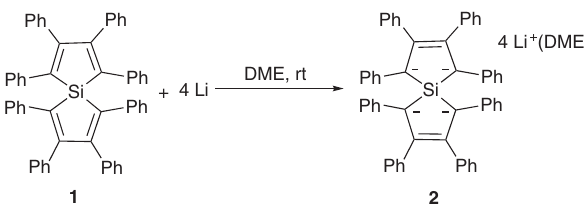
Table 1: 13 C, 29 Si, and 7 Li NMR chemical shifts of reported 2,5-carbanion silole anions. 2,5-Carbanion silole anions [Ph